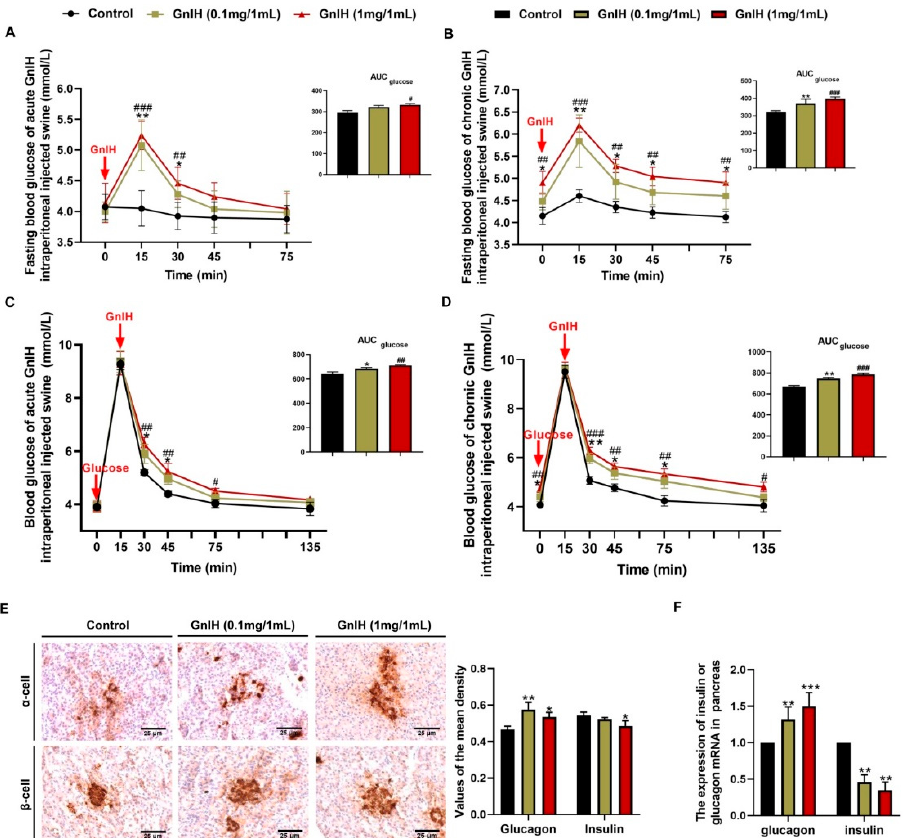
Figure 3. Effects of intraperitoneally injected GnIH on glucose homeostasis and islet histomorphology changes. ( A , B ) The fasting blood glucose levels of piglets were measured at different time points after intraperitoneally injecting different acute ( A ) or chronic ( B ) doses of GnIH or vehicle into rats that had fasted for 8 h. The upper panel shows the total area under the curve (AUC) for fasting blood glucose after GnIH or vehicle injection from 0 to 60 min. ( C , D ) For the intraperitoneal glucose tolerance test, blood glucose concentrations were measured in ad libitum-fed piglets that had been administered different acute ( C ) or chronic ( D ) doses of GnIH or vehicle. The upper panel shows the total AUC values for blood glucose after the administration of different doses of GnIH or vehicle from 0 to 120 min. ( E ) Representative immunohistochemistry images and mean densitometric values for glucagon or insulin in islets of pancreatic sections from piglets administered different chronic doses of GnIH or vehicle for 14 days. Scare bars: 25 µ m. ( F ) Glucagon - and insulin -related gene expression in the pancreases of piglets administered different chronic doses of GnIH or vehicle for 14 days. n = 5/group. The data are presented as the means ± SEM. * p < 0.05, ** p < 0.01 and *** p < 0.001 GnIH 0.1 mg/1 mL vs. vehicle; # p < 0.05, ## p < 0.01 and ### p < 0.001 GnIH 1 mg/1 mL vs.